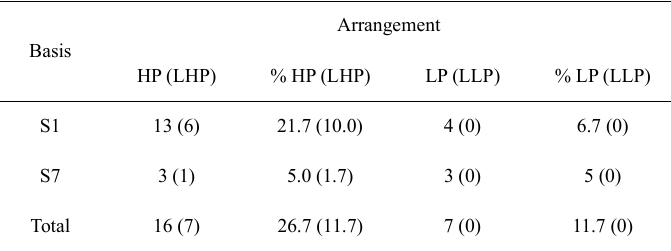
Table 2 shows the number and probability (percentage) of the Hlg pores fitting the HP and LP patterns in the 60 pores. The numbers in parentheses mean the number and probability (percentage) of the LHP in the HP or the LLP in the LP. There is no pore fitting in the LLP.